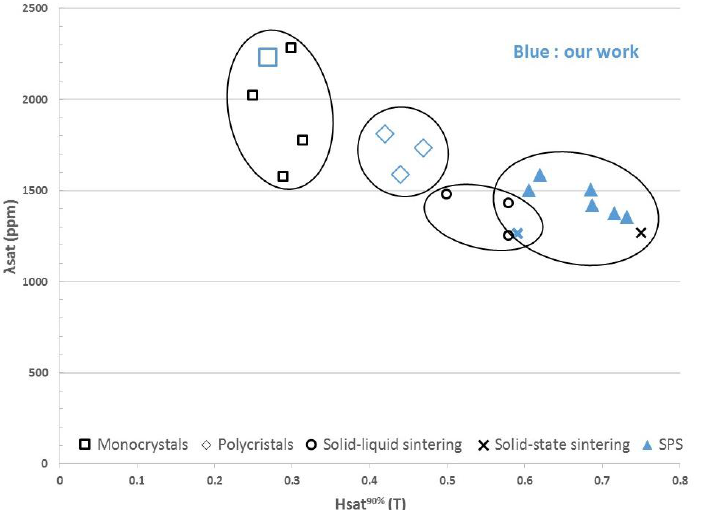
Figure 6. “Performance phase diagram per technique” as λ sat vs. Hsat 90% (field required to reach 90% of λ sat). Blue symbols are our work, black symbols are from